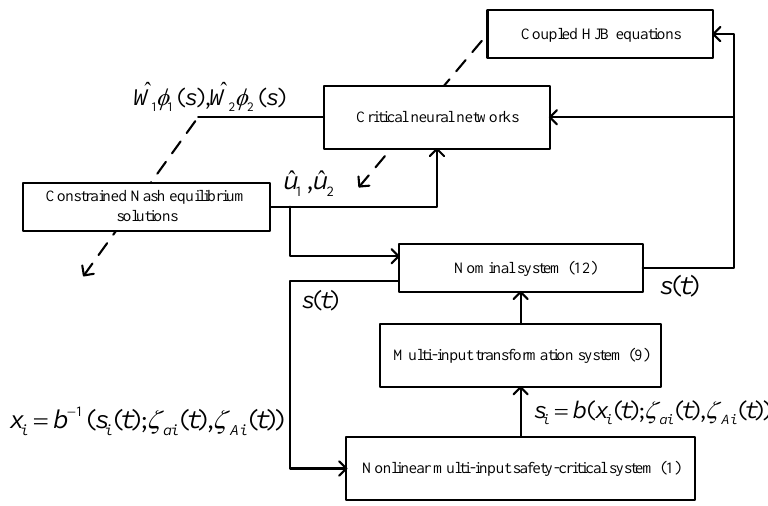
Figure 1. The structure diagram of the proposed multi-input safety-critical